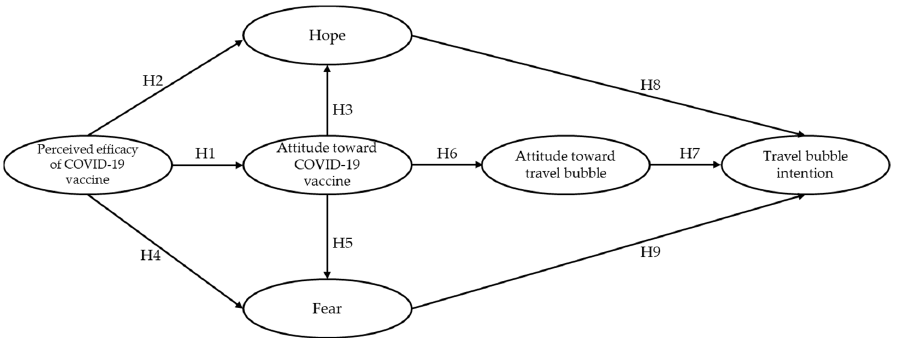
Figure 1. Proposed conceptual model.